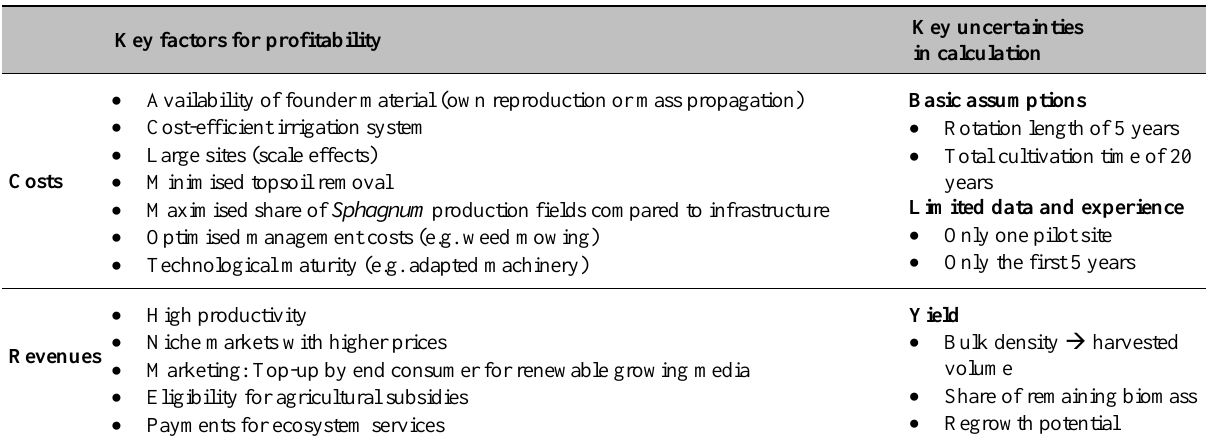
Table 3. Key factors for profitability of Sphagnum farming and key uncertainties in calculation. Key factors for